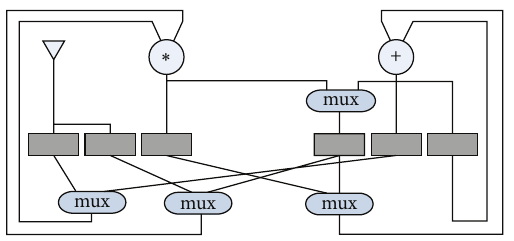
Figure 5: RTL structure of (1) from a PLF schedule S 2 . It has one port and uses minimum functional